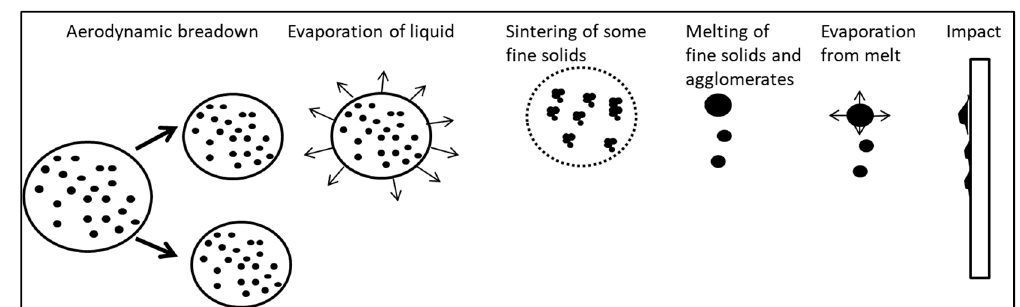
Figure 6. Phenomena occurring after injection of suspension droplet into plasma jet [14]. Reproduced with permission from [Wiley Books], John Wiley and Sons, 2012.